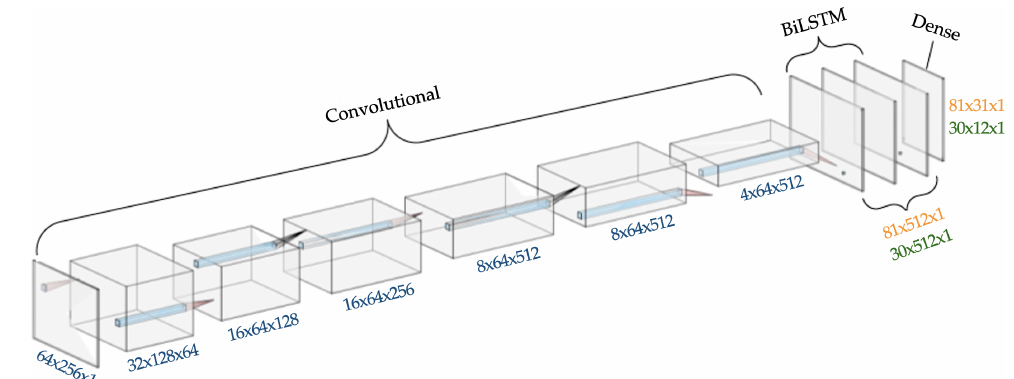
Figure 6. Layer graph of the BiLSTM network. Orange and green values show the dimensions for the pretraining network and our chess move recognition network, respectively. Pooling, batch normalization, and reshaping layers are not